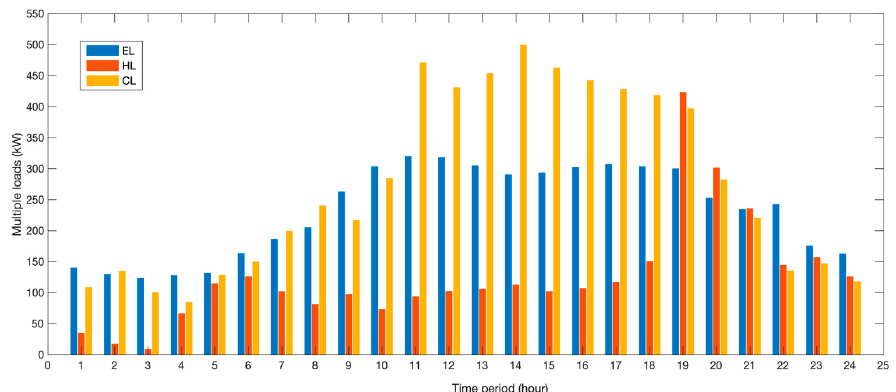
Figure 4. Hourly data of forecasted wind power output and electricity price.